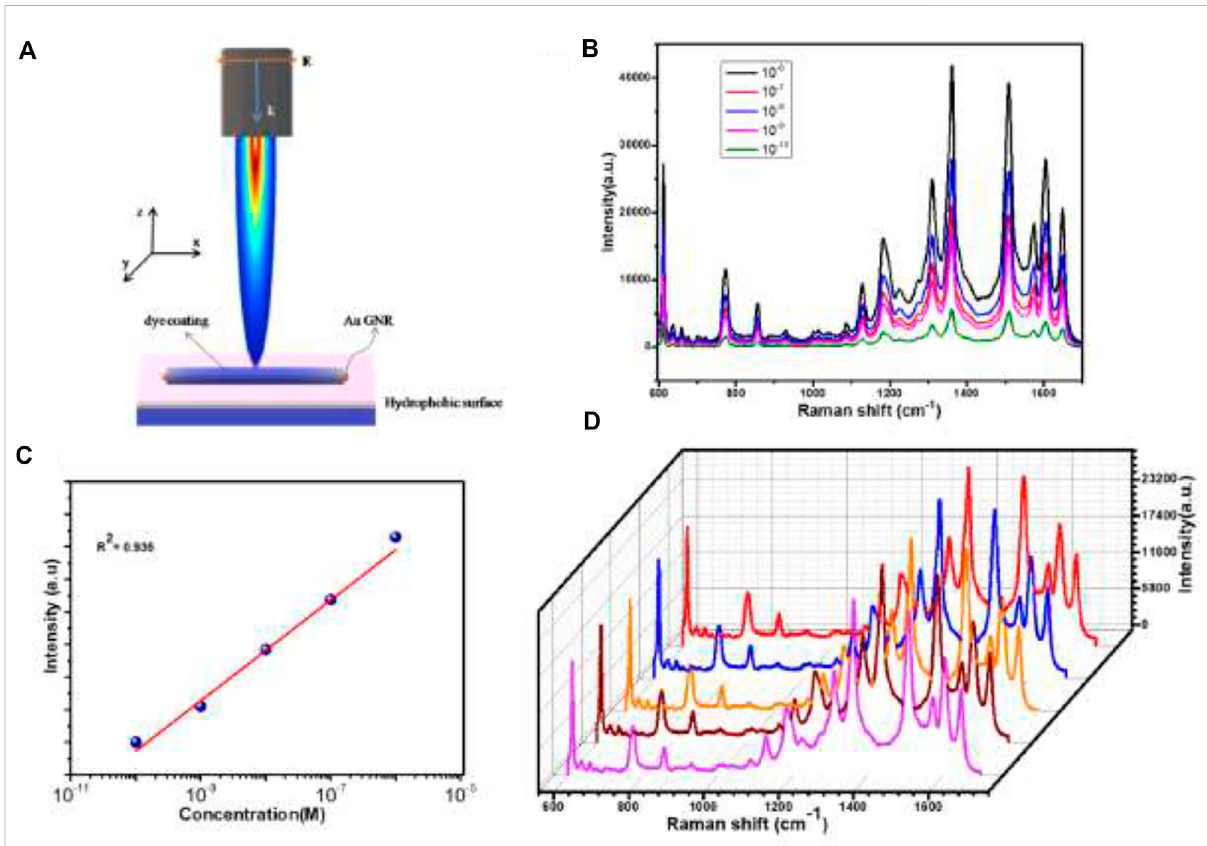
FIGURE 4 (A) Schematic diagram of GNRs coupling with dye analyte on a hydrophobic surface as a strategy to increase the electric fi eld enhancement effect (B) Raman scattering spectra of various concentrations of solutions. (C) The peak intensities of various concentrations at 1,340 cm − 1 (D)